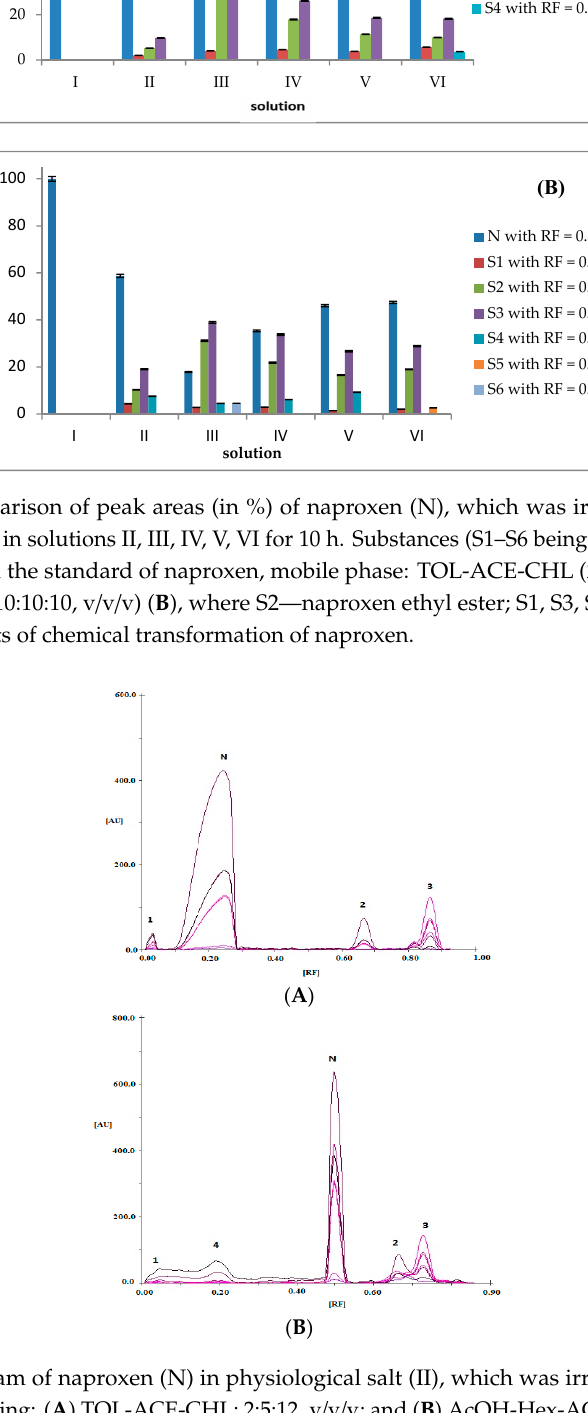
Figure 5. Densitogram of naproxen (N) in physiological salt (II), which was irradiated (254 nm) for 10 h and analyzed using: ( A ) TOL-ACE-CHL; 2:5:12, v/v/v; and ( B ) AcOH-Hex-ACE, 0.10:10:10 v/v/v as mobile phases, where: 1, 2, 3, 4—degradation products of naproxen; and 2 was identified as naproxen ethyl ester.